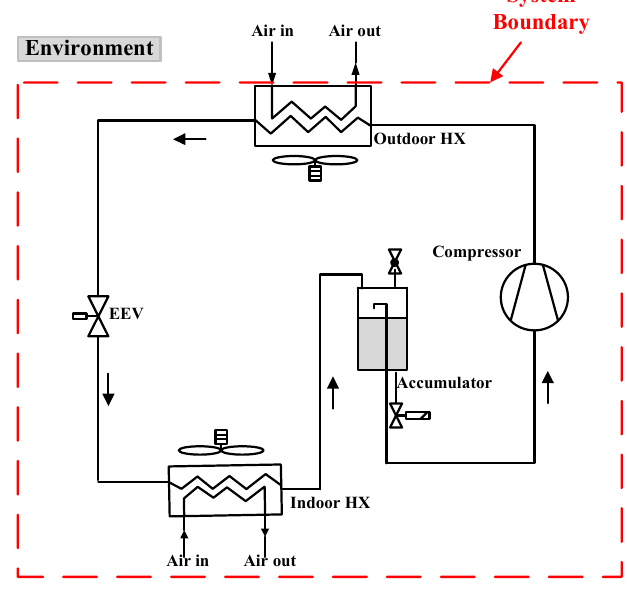
Figure 3. The boundary in the exergy analysis.